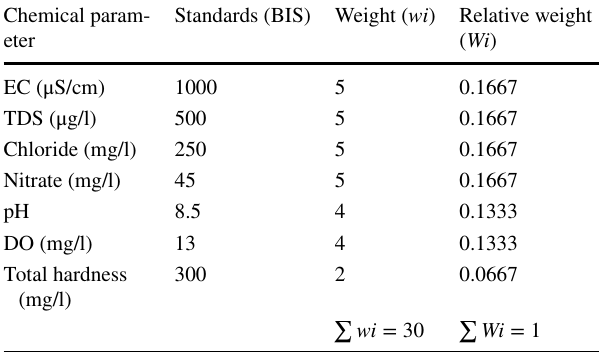
Table 2 Relative weight of chemical parameters (BIS 1991) Chemical param- eter